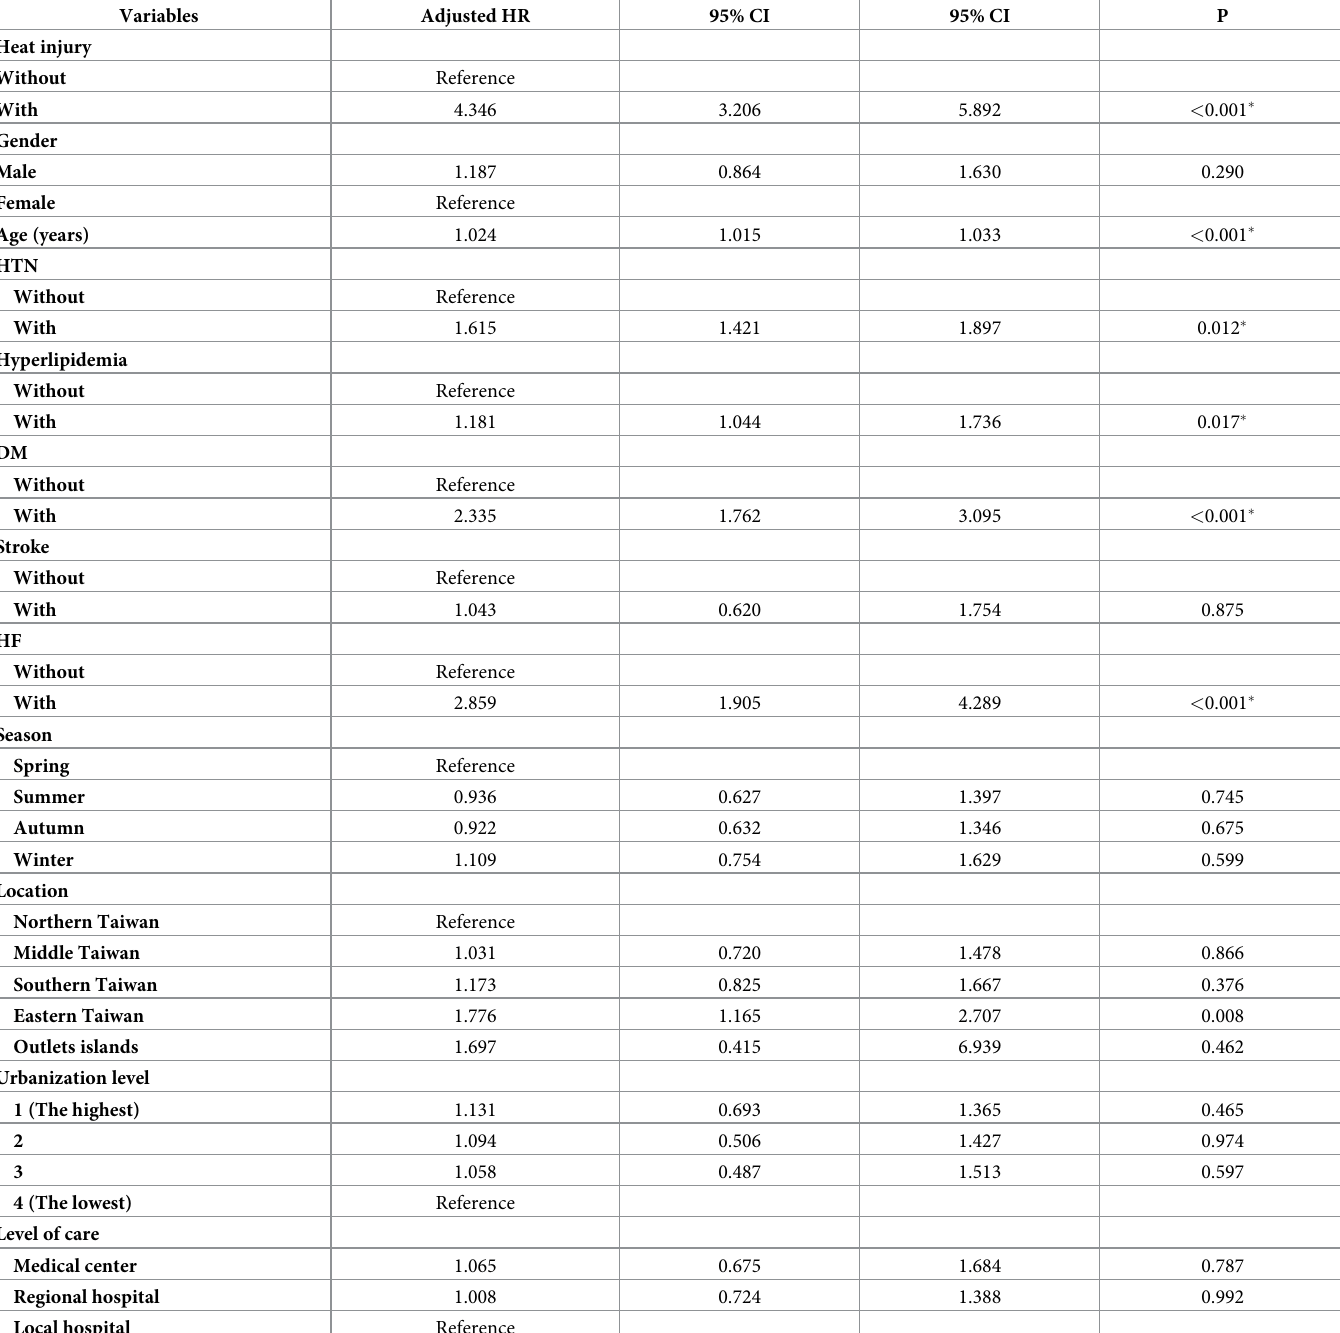
Table 2. Hazard ratio of chronic kidney disease in association with baseline characteristics among heat injury patients in Cox model with competing